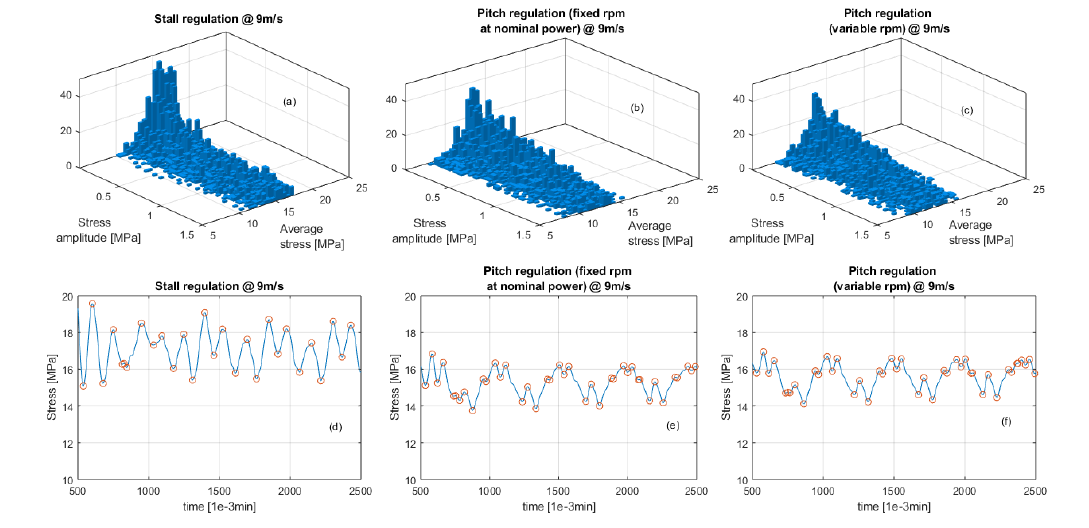
Figure 9. Results of the rainflow analysis for 9 m/s. Upper row ( a – c ): results of the rainflow analysis for the three regulation schemes. Lower row ( d – f ): corresponding time series with inflection points